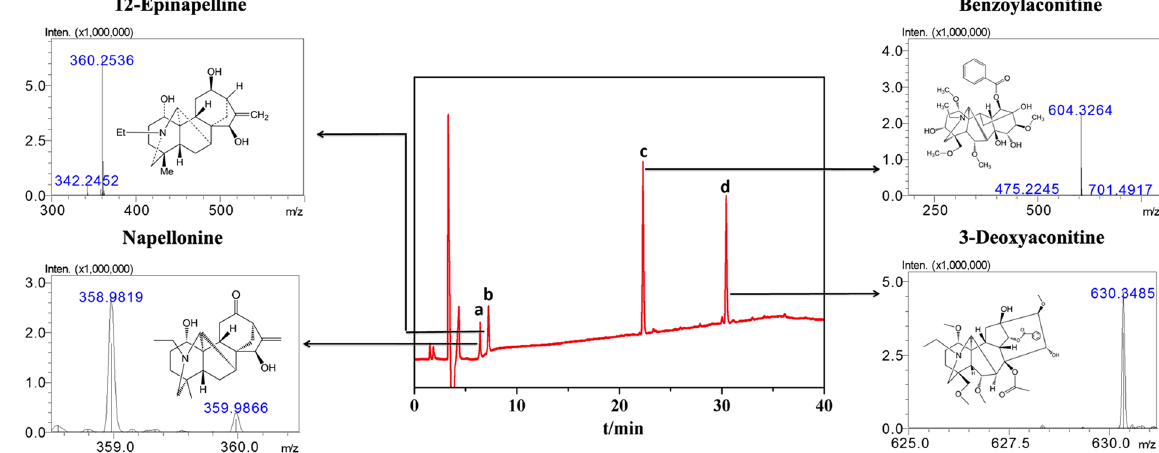
Figure 6. HPLC/MS chromatograms of eluent fraction and main four retention peaks ( a , b , c and d ) were identified as napellonine, 12-epinapelline, benzoylaconitine and 3-deoxyaconitine, respectively.